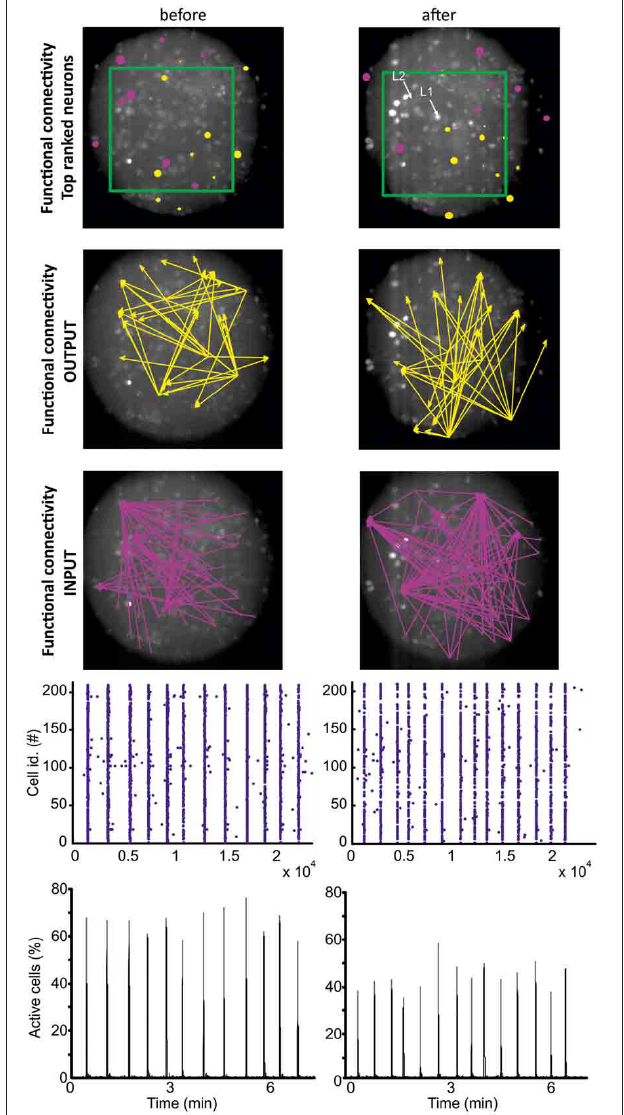
FIGURE 3 | Directed functional connectivity before (left) and after (right) lesion. The number of OUTPUT and INPUT functional connections has been calculated for all the imaged neurons based on the temporal correlation between the firing onsets of the neurons (see section “Materials and Methods”). The ten top ranked cells, i.e., the cells with the largest number of functional OUTPUT (yellow) and INPUT connections (pink), are represented in the top row. For graphic clarity, the connectivity graphs shown in the 2nd and 3rd rows (respectively INPUT and OUTPUT connections) include only the five top ranked cells. The data refers to a homogenous neuronal network where functional hub cells (i.e., neurons with a very large number of functional connections) were not identified. The fluorescent images show the cells loaded with the calcium indicator Fluo4 (see section “Materials and Methods”). The locations of the two lesions (L1 and L2) are marked by the white arrows. The green rectangle highlights the region shown in Figure A1 . The field of view is a circular region of 244 μ m diameter. The raster plot (representing the firing onsets) and the fraction of activated cells are shown respectively in the 4th and 5th